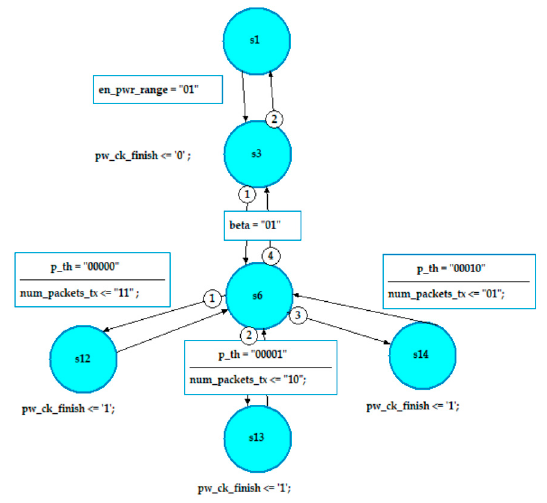
Figure 12. Part of the FSM for the proposed Pth_range_ck block.